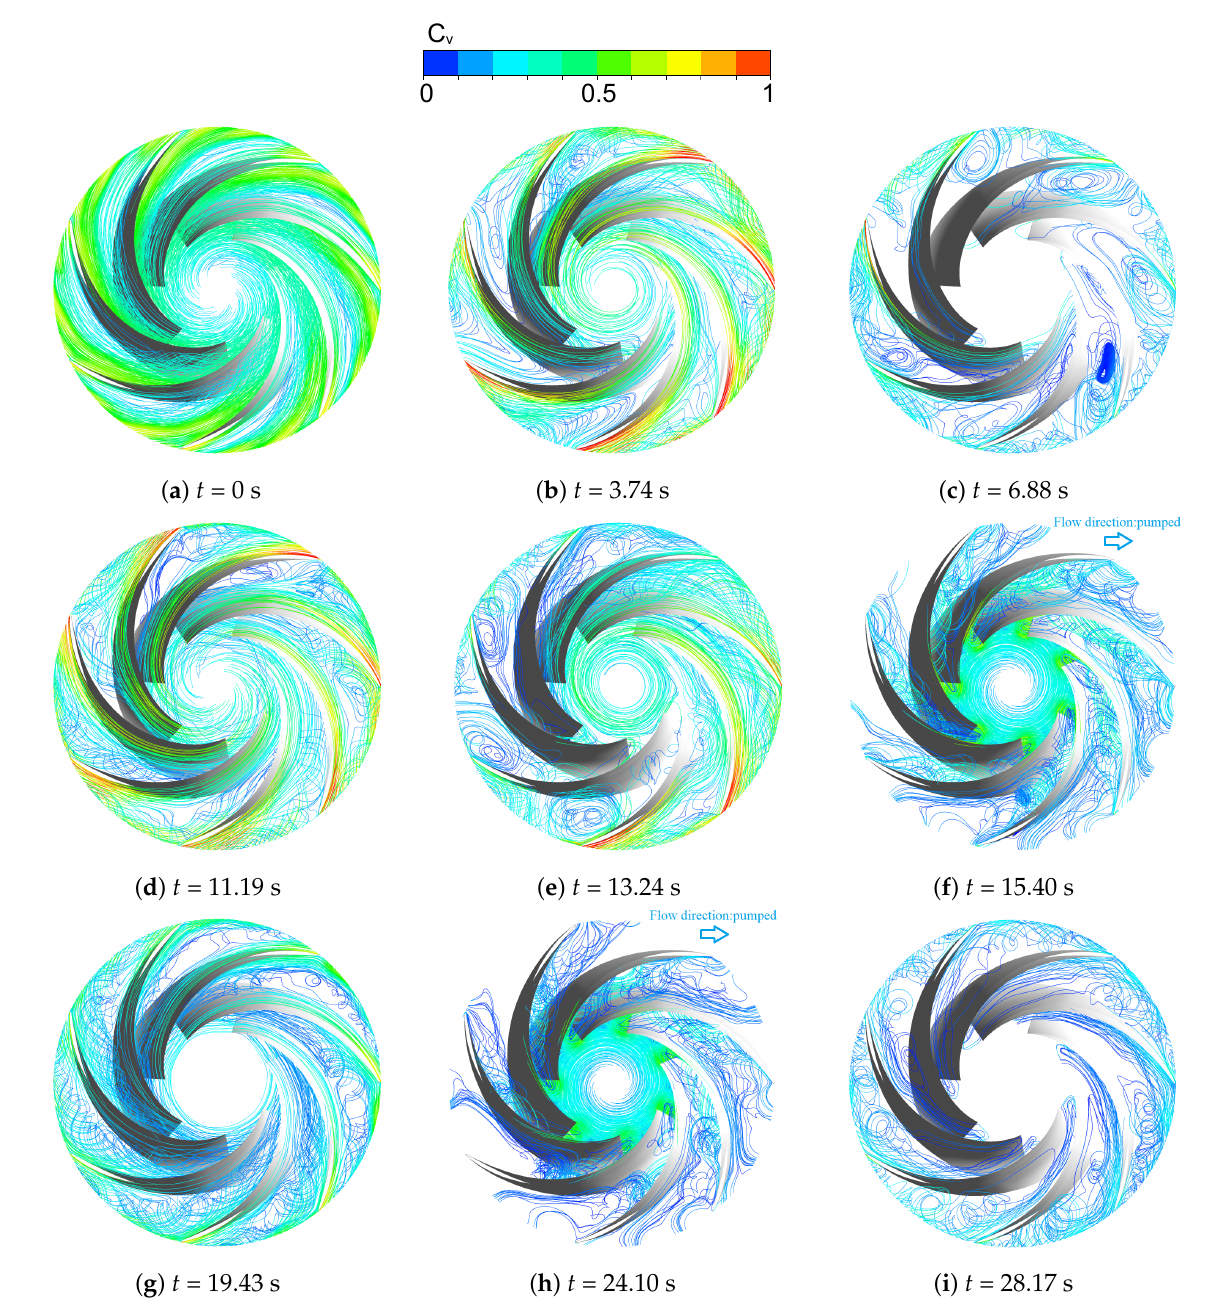
Figure 9. Flow pattern in the runner